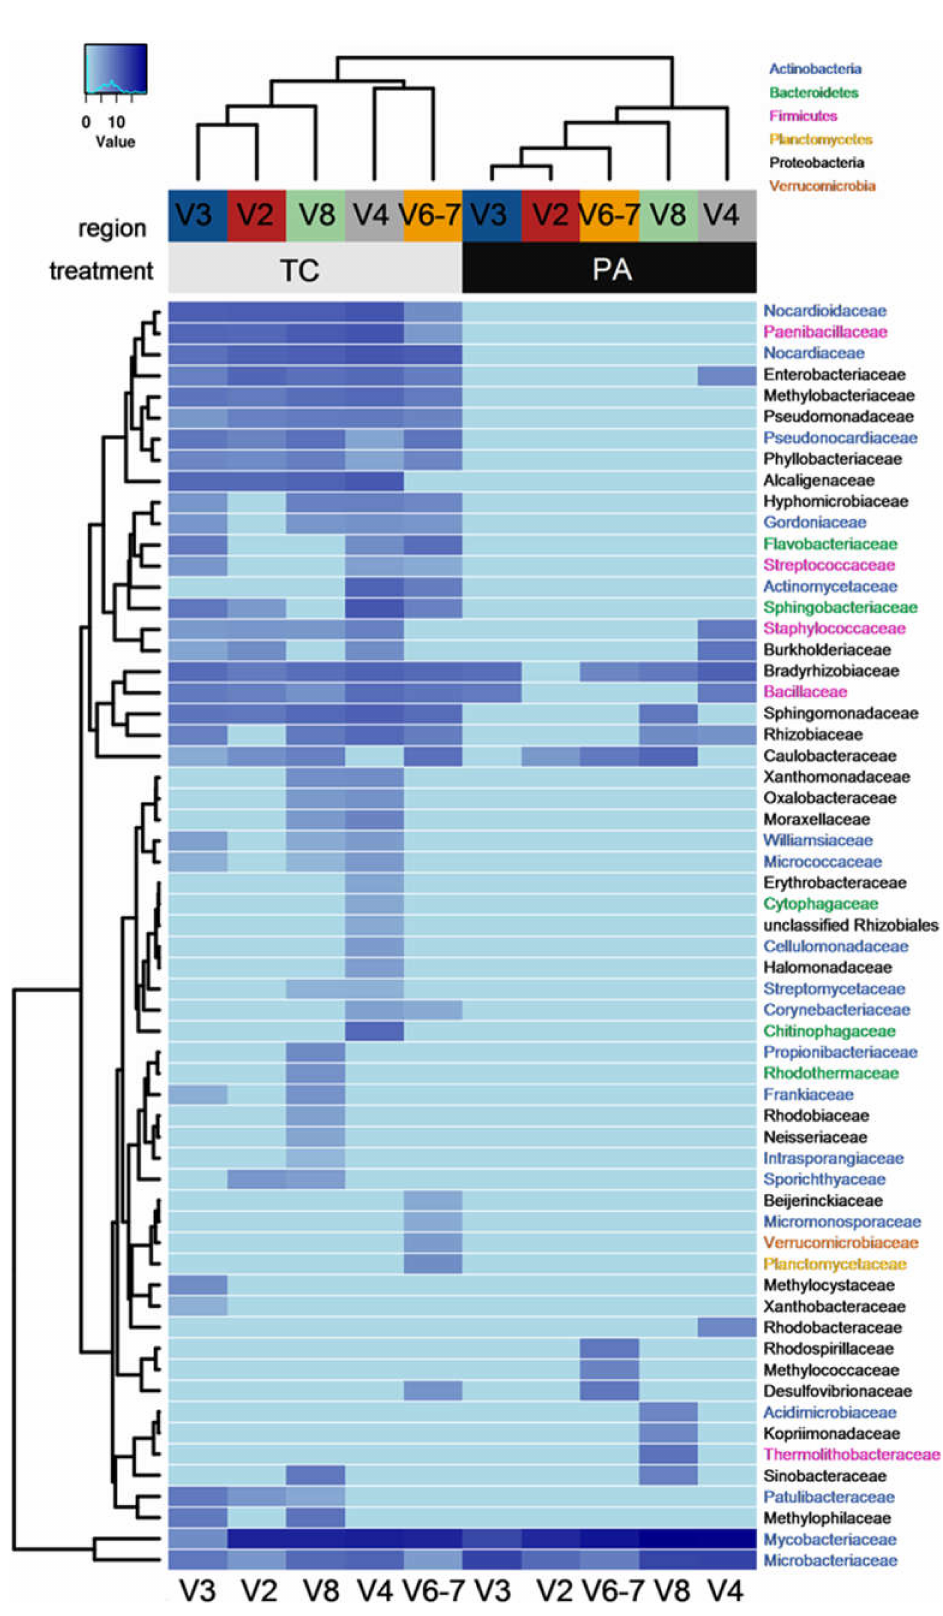
Figure 5. Family-level distribution of reads mapped to high-abundance families generated using five variable 16S rRNA region-specific primer pairs for the control (TC) and post-antibiotic treatment (PA) samples of the tobacco in vitro shoots. Data shown in Supplementary Material Table S1. Different font colors represent classes of the Bacteria